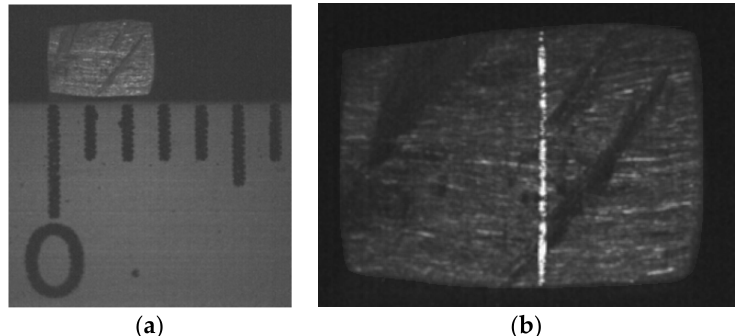
Figure 5. ( a ) Metallic object surface with scale in mm in x -axis. ( b ) Micro laser line projected on the object surface.